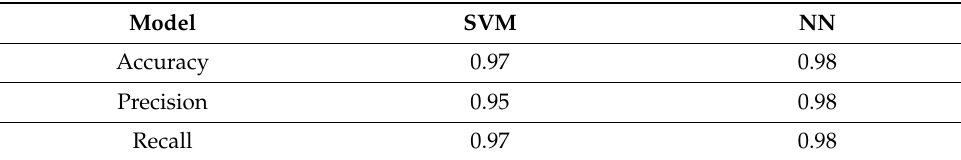
Table 2. Classification performances: standard algorithm.